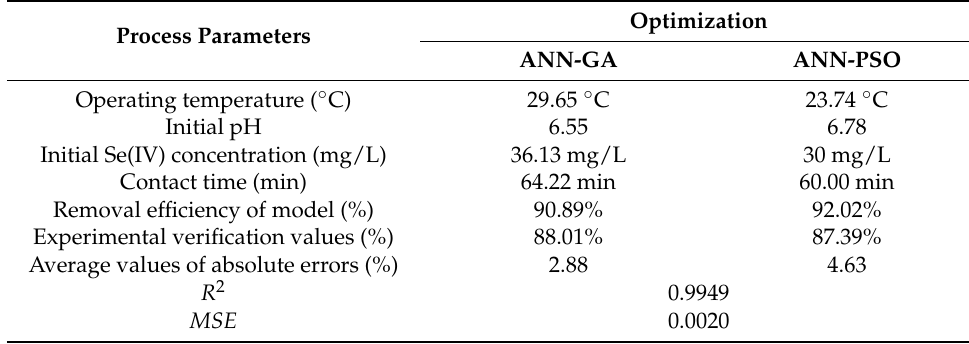
Table 4. The optimized process parameters for Se(IV) removal by nZVI/rGO composites using different methods.